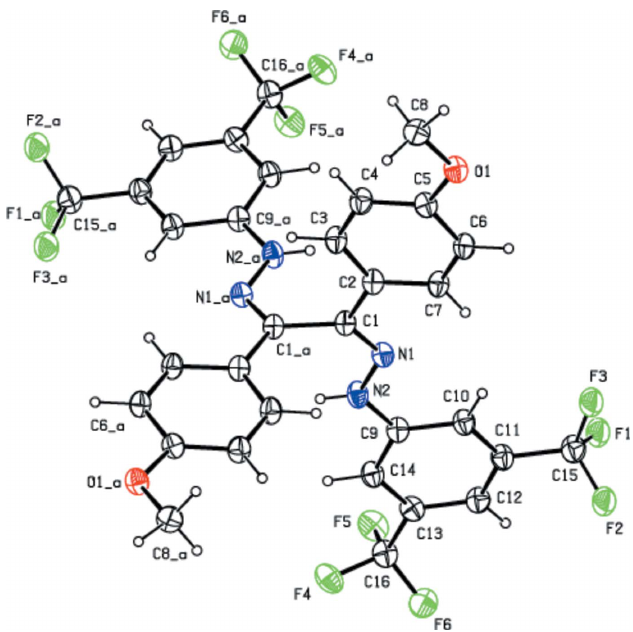
Figure 1 The molecular structure of the title compound with displacement ellipsoids for non-H atoms drawn at the 20% probability level. The minor components of the disordered CF 3 group have been 5(4 H )-one and 3-methyl-4-[( Z )-2-(4-methylphenyl)hydrazin- 1-ylidene]-1-[4-(trifluoromethyl)phenyl]-\1 H -pyrazol-5(4 H )- one (Alvarez-Thon et al. , 2014).